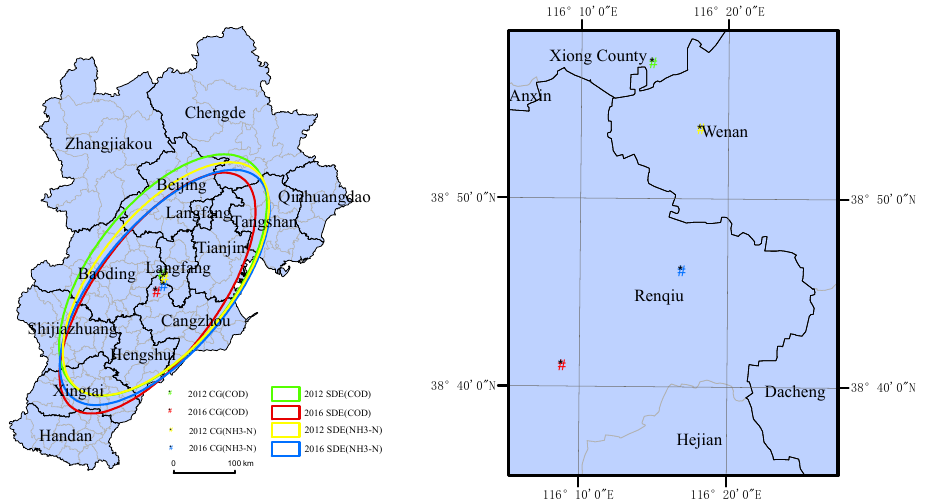
Figure 5. Center of gravity (CG) of water pollutants discharge in the Beijing–Tianjin–Hebei region and standard deviational ellipse (SDE).